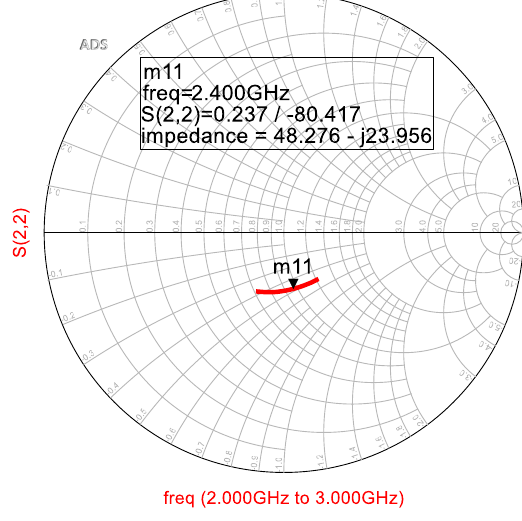
Fig. 8. Output impedance value